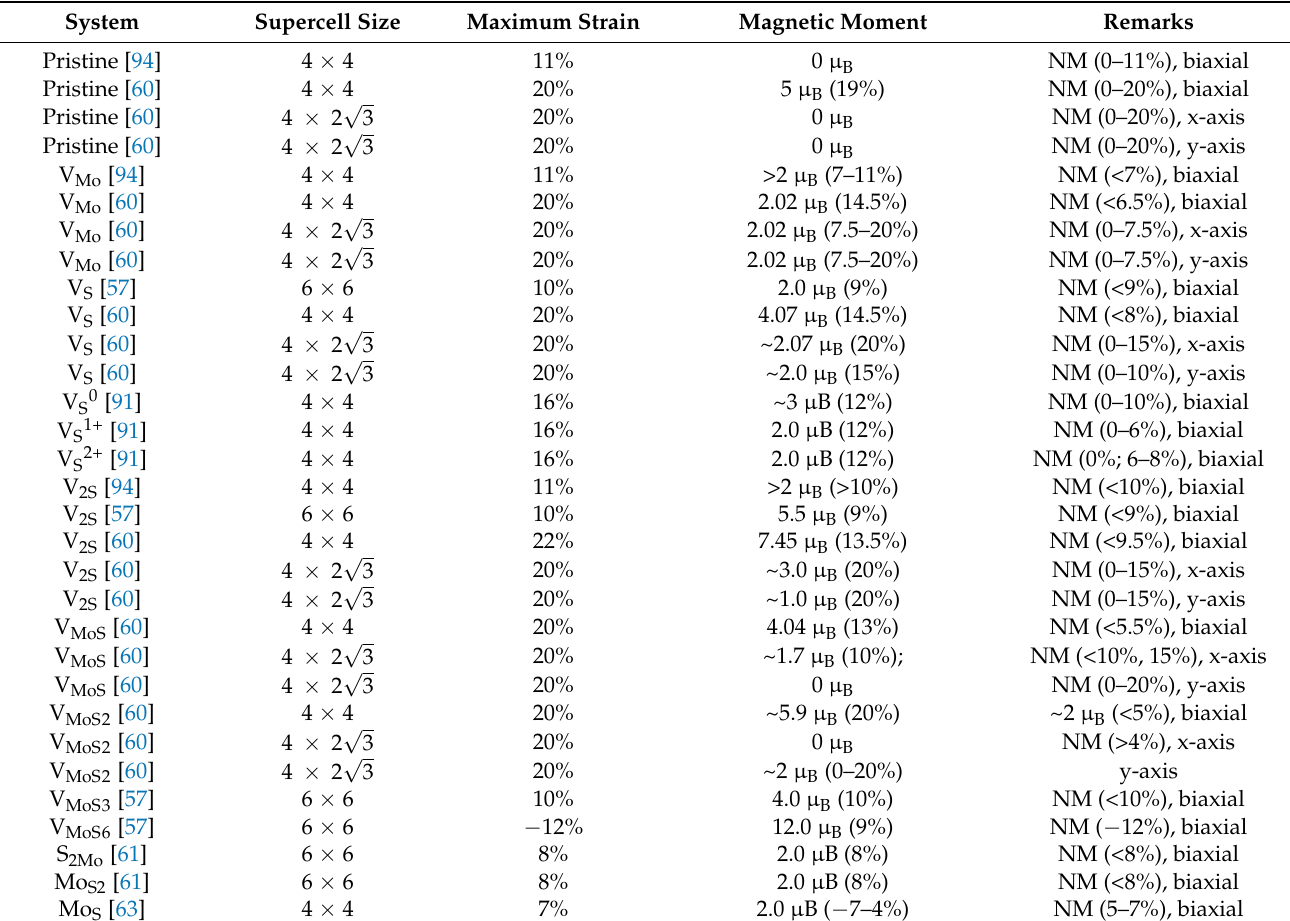
Table 1. Strain-dependent magnetism of single-layer MoS 2 with various